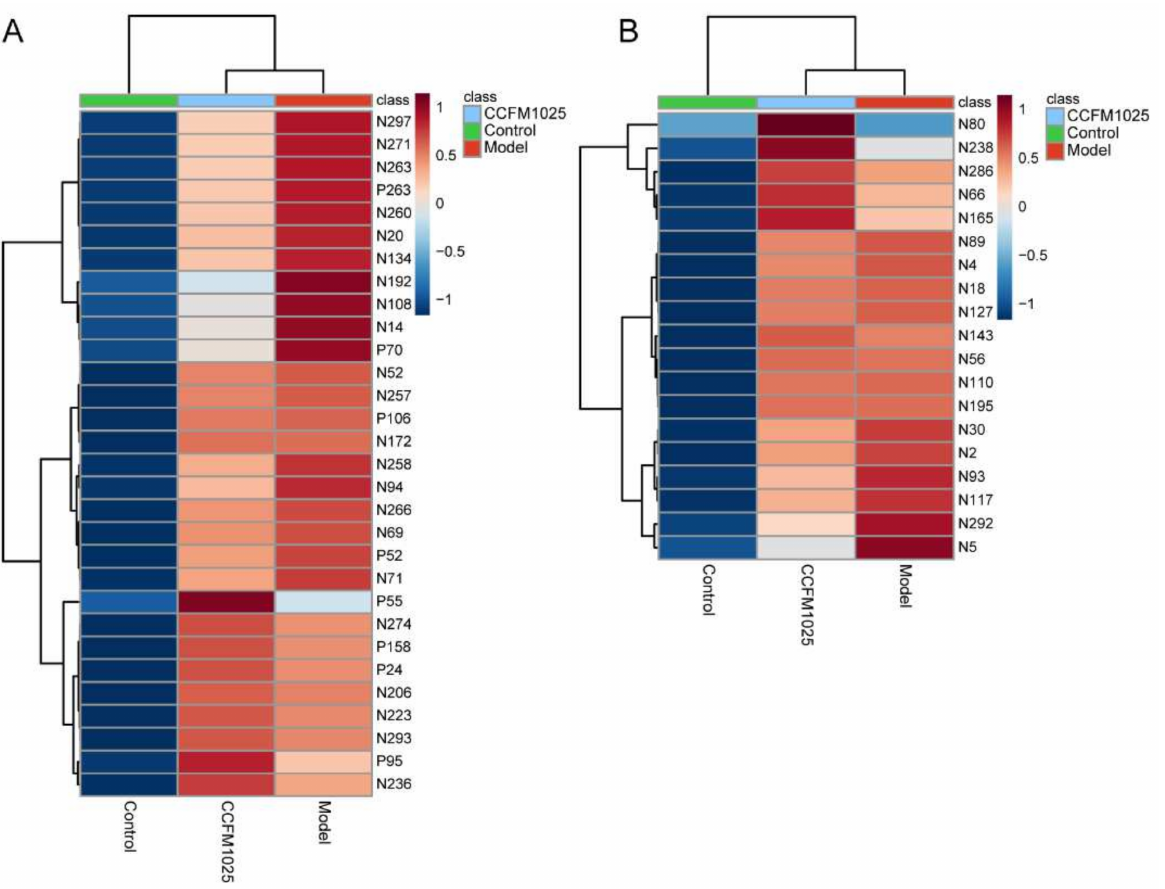
Figure 3. Hierarchical cluster analysis of differential metabolites among the control, model, and B. breve CCFM1025 groups in serum ( A ) and hippocampus ( B ) samples, respectively. Among-group comparisons were performed using one-way ANOVA. The name of differential metabolites was listed in Supplementary Tables S1 and